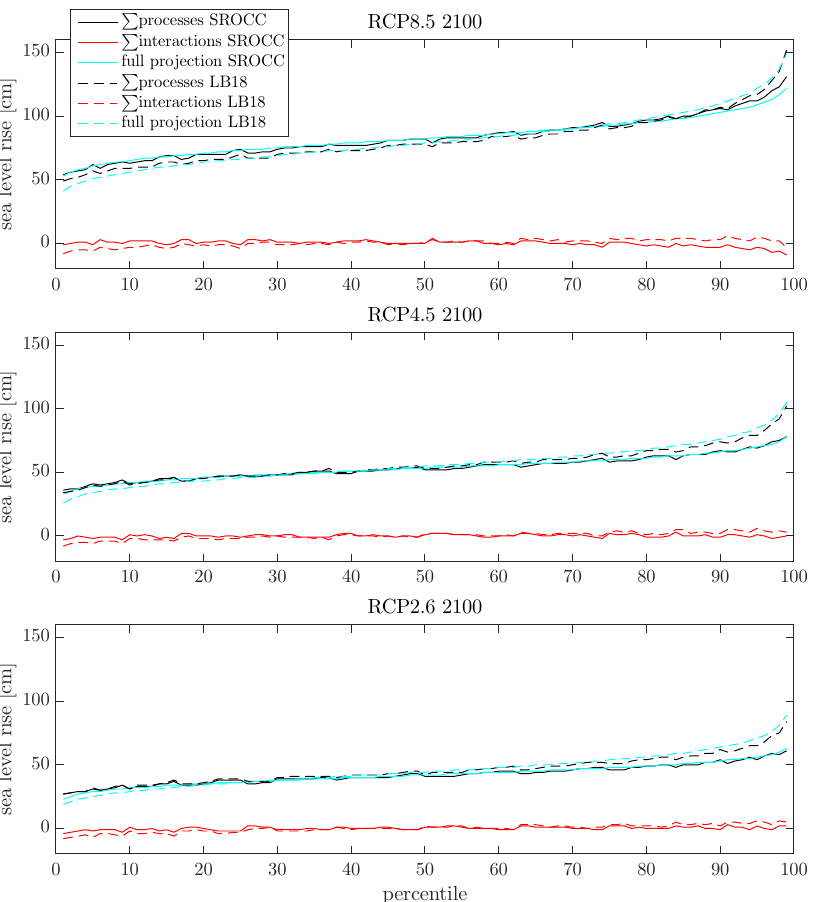
Figure 5. Comparison of the sum of the interaction and forcing terms to the total projections shown in Figures